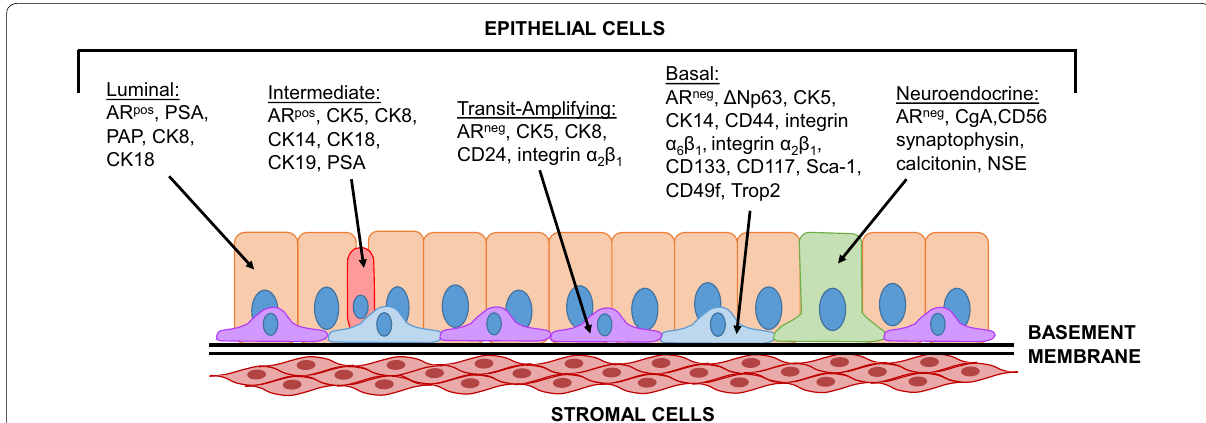
Fig. 2 Schematic of the different cell types in the prostate and their identifying markers. The epithelial compartment is composed of three basic cell types: basal, luminal, and neuroendocrine cells, and two intermediate phenotypes. Basal cells are non‑secretory cells located along the basement membrane of the epithelium and are characterized by the following markers: ΔNp63 (a member of p53 transcription factors family) [150], cytokeratins 5 and 14 (CK5 and CK14) [151, 152], CD44 [153], integrin α 2 β 1 [65], integrin α 6 β 1 [154, 155], CD133 [65], CD117 [66], Sca‑1 [66, 156], CD49f [157], and tumor‑associated calcium signal transducer 2 (Trop2) [157]. Basal cells give rise to secretory luminal cells by transitioning through intermediate states. Two intermediate phenotypes have been described: (1) transit‑amplifying cells which are non‑secretory and exhibit a more basal‑like phenotype and (2) intermediate cells which are secretory and exhibit a more luminal‑like phenotype. Both, transit‑amplifying and intermediate cell types may express cytokeratin profiles similar to basal or luminal cells, however, only transit‑amplifying cells have been shown to express CD24 to distinguish them from low differentiated basal cells [158] and only intermediate cells have been shown to express CK19 to distinguish them from luminal cells [159]. Luminal cells are secretory columnar cells that express high levels of androgen receptor (AR), cytokeratins 8 and 18 (CK8 and CK18), and prostatic acid phosphatase (PAP) [160]. Lastly, neuroendocrine cells are very rare cells located in the luminal layer and represent less than 1% of the prostatic epithelium. They are non‑secretory, differentiated cells that express chromogranin A (CgA), CD56, synaptophysin, calcitonin, and neuron specific enolase (NSE) [161, 162]. This figure has been adapted from diagrams in related literature